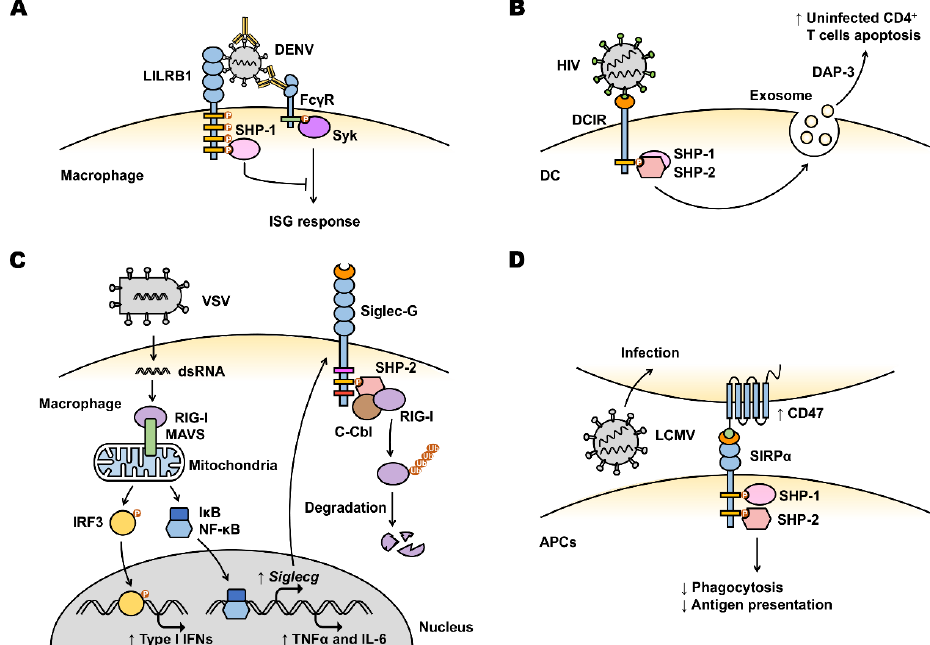
Figure 2. Viruses manipulate host inhibitory receptors for immune evasion. ( A ) Dengue viruses (DENV) opsonized with antibodies are taken up via Fcγ receptors (FcγR) on macrophages. By co - ligating LILRB1, DENV can inhibit FcγR signaling and IFN-stimulated gene (ISG) responses. ( B ) Human immunodeficiency virus (HIV) attaches to dendritic cells (DCs) via DCIR. HIV-pulsed DCs release more exosomes containing pro-apoptotic protein DAP-3, inducing apoptosis of neighboring uninfected CD4 + T lymphocytes. ( C ) RIG-I recognizes vesicular stomatitis virus (VSV) and induces Siglecg expression. The increased Siglec-G inhibits immune response by recruiting phosphatase SHP-2 and the E3 ubiquitin ligase c-Cbl to RIG-I, resulting in RIG-I degradation. ( D ) Cells infected with lymphocytic choriomeningitis virus (LCMV) have an upregulated expression of CD47, which mediates the “don’t eat me” signal by interactin g with SIRPα. The CD47 - SIRPα axis impairs phag- ocytosis and antigen-presenting capabilities in antigen-presenting cells (APCs). Table 1. Viral manipulation of inhibitory receptors on myeloid cells.